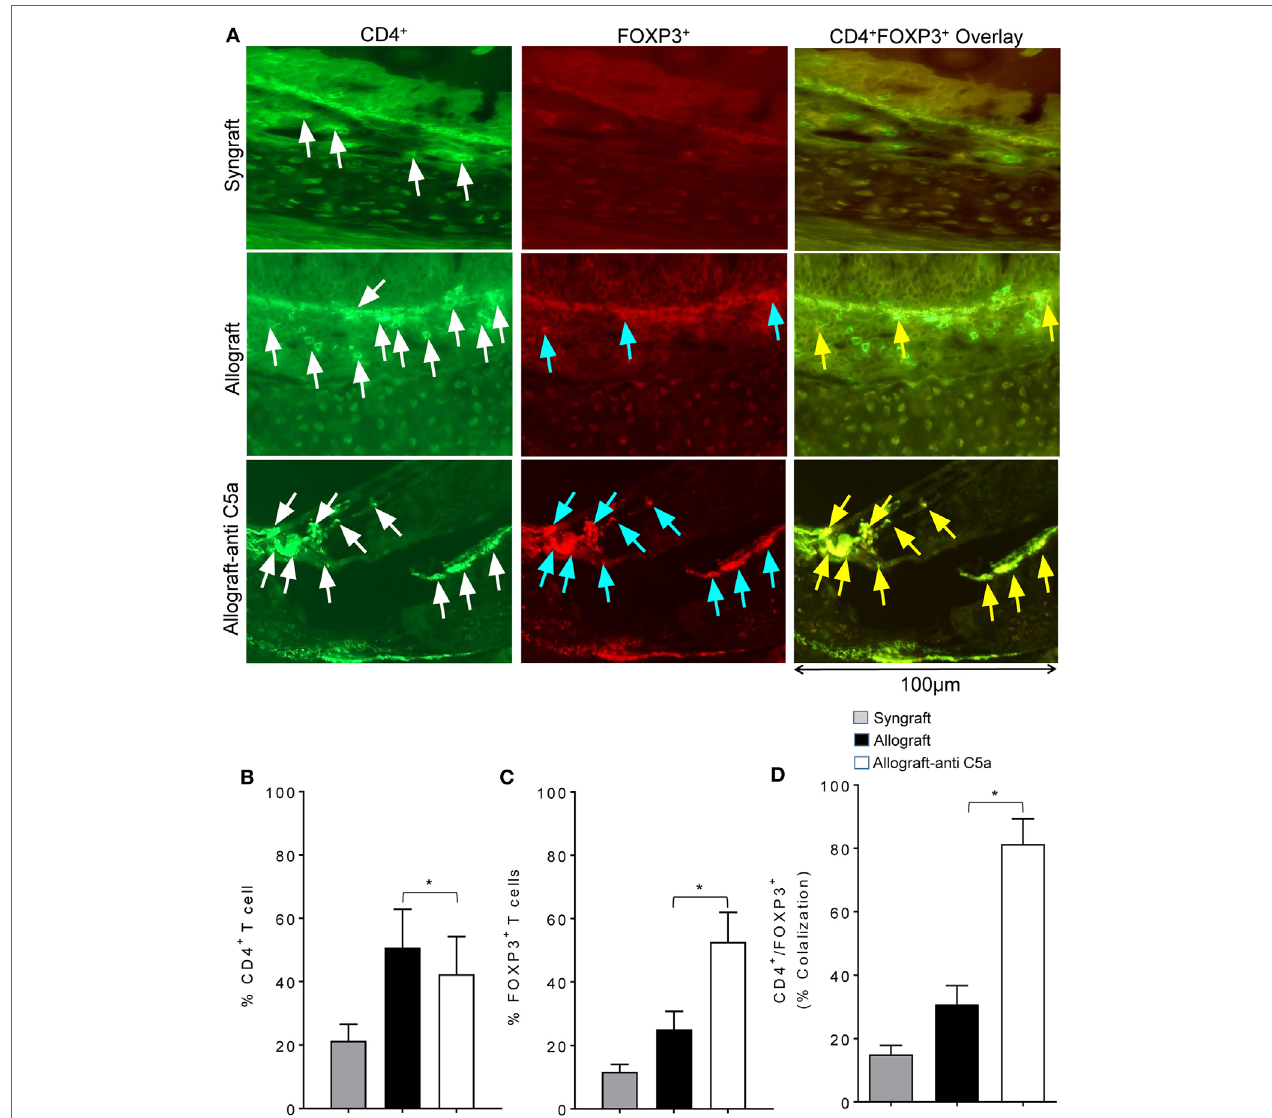
FigUre 2 | C5a blockade increased infiltration of regulatory T cell (Treg) in allograft. (a) Immunofluorescent staining for CD4 and forkhead box P3 (FOXP3) at d10 posttransplantation. (B–D) Morphometric analysis of graft infiltrating CD4 + T cells, FOXP3 + cells, and CD4 + FOXP3 + colocalization (Tregs). Arrows highlighted individual CD4 + T cells (white arrows), FOXP3 + cells (blue arrows), and CD4 + FOXP3 + Tregs (yellow arrows). Data are presented as means with SE of 3–4 transplants/time point/experiment, and repeats of three different experiments. * p < 0.05. Original magnification, ×